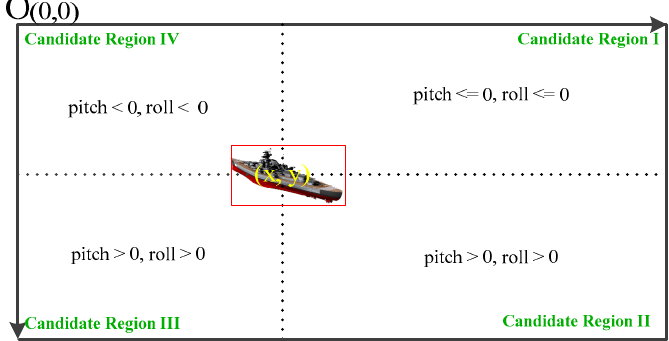
Figure 5. Sketch map of adaptive association gate of appearance.